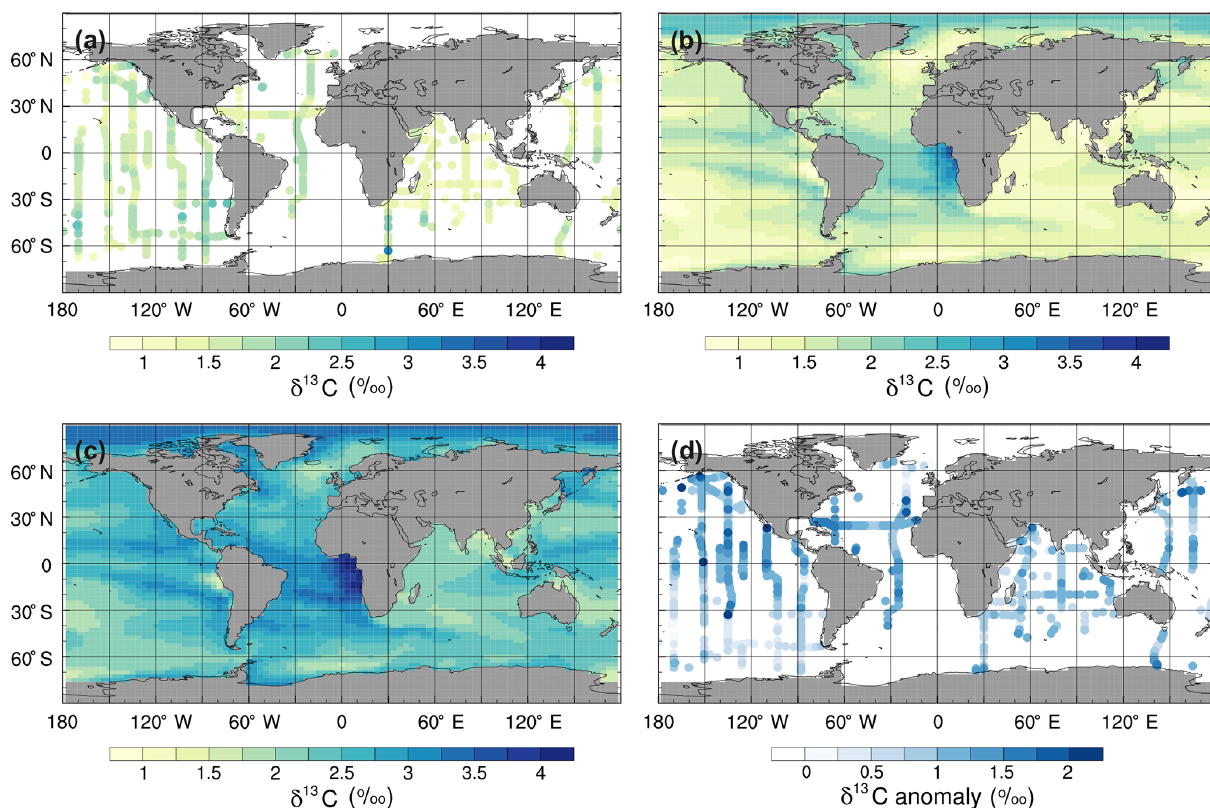
Figure 7. Mean annual surface δ 13 C DIC during the 1990s: (a) observations from GLODAPv2 (Key et al., 2015; Olsen et al., 2016), (b) the std simulation corrected for the mean surface bias (0.97‰), which is calculated as (cid:80) (simulated-observed)/number of observations, (c) the std simulation, and (d) std minus